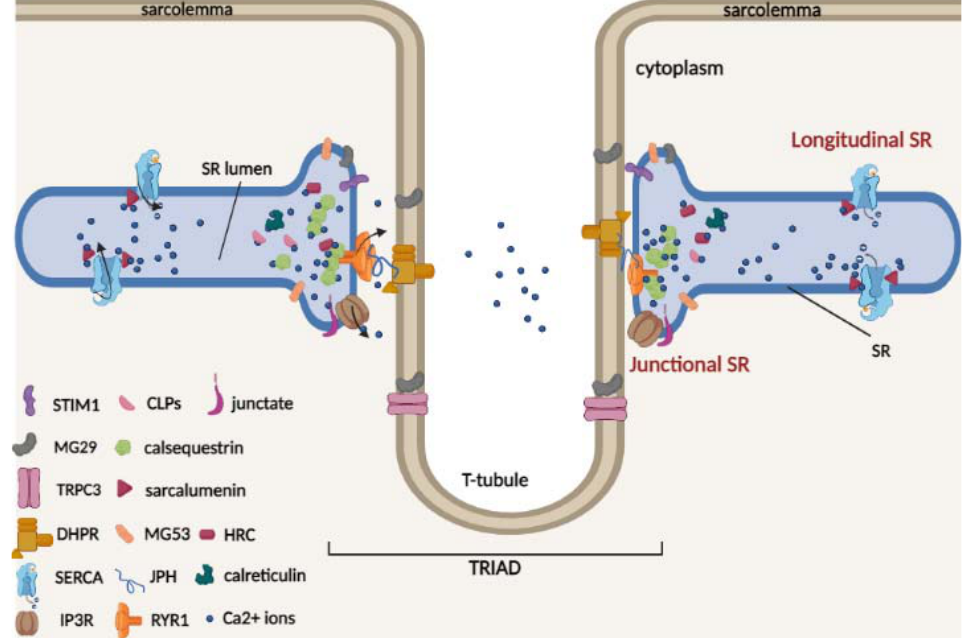
Figure 1. Schematic model of two terminal cisternae on the opposite sides of a central t ‐ tubule (triad) and of the luminal Ca² ⁺‐ binding proteins of skeletal muscle. In the triad, the voltage ‐ activated L ‐ type Ca² ⁺ channel dihydropyridine receptor (DHPR) is located on the t ‐ tubule, and the ryanodine receptor Ca² ⁺ release type 1 channel (RyR1) is located on the SR. The triad is stabilized by junctophilin (JPH) proteins, which act as structural bridges between the t ‐ tubule and the SR membrane. TRPC3 protein is located on the sarcolemma and can interact with mitsugumin 29 (MG29). The SR/ER Ca² ⁺ ATPase (SERCA) pumps are located on the longitudinal SR. RyR1, stromal interaction molecule 1 (Stim1), inositol ‐ trisphosphate receptor (InsP3R), and mitsugumin 29 (MG29) and 53 (MG53) are located in the junctional SR. The Ca 2+ buffer proteins calsequestrin (CSQ), histidine ‐ rich Ca² ⁺ (HRC) ‐ binding protein and the calsequestrin ‐ like proteins (CLPs) are located in the lumen of the junctional SR, while sarcalumenin (SAR) protein is located in the lumen of longitudinal SR.